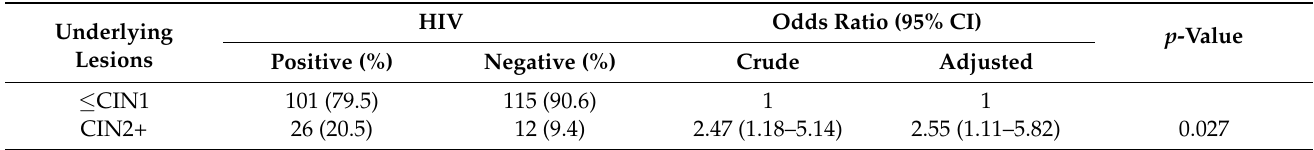
Table 2. Underlying CIN2+ in women with LSIL cytology by HIV Status.